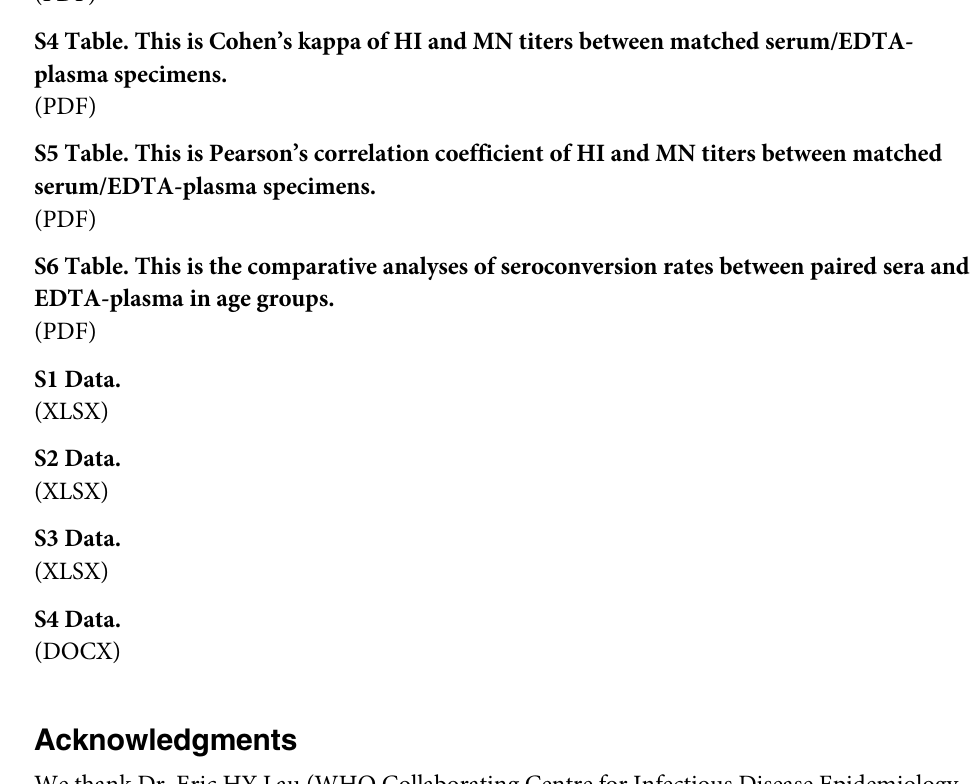
S3 Table. This is ICC values of MN titers in pairs after excluding seronegative pairs under the definition of absolute agreement versus consistency. S4 Table. This is Cohen’s kappa of HI and MN titers between matched serum/EDTA- plasma specimens. S5 Table. This is Pearson’s correlation coefficient of HI and MN titers between matched serum/EDTA-plasma specimens. S6 Table. This is the comparative analyses of seroconversion rates between paired sera and EDTA-plasma in age